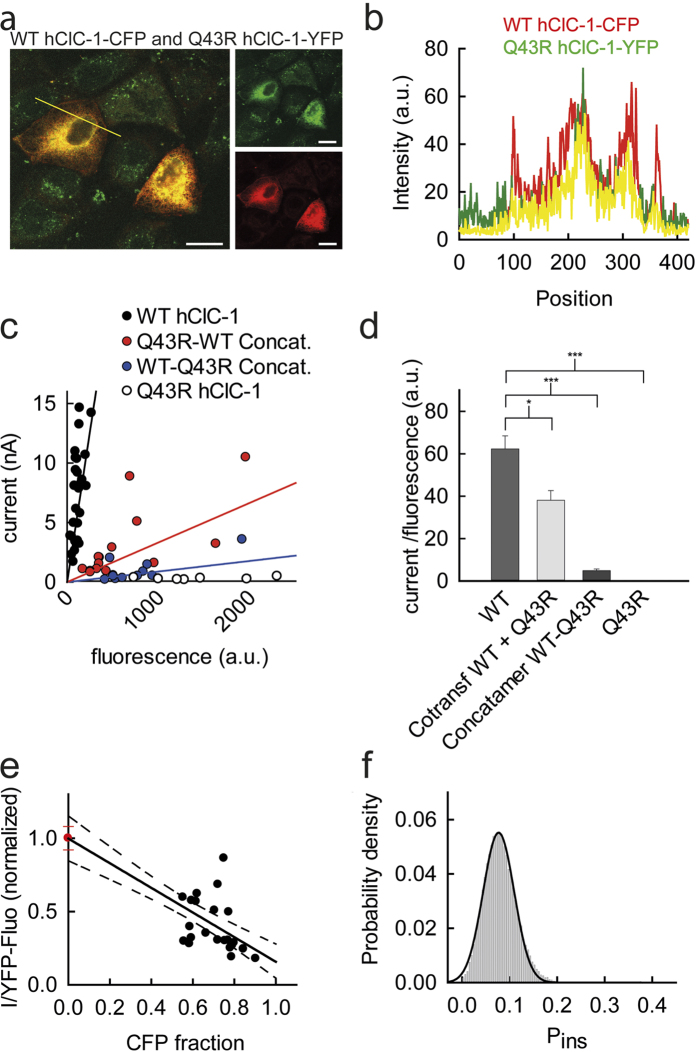
Heterodimeric channels assembled from WT and Q43R hClC-1 exhibit a reduced surface membrane insertion probability.(a,b) Confocal image (a) and corresponding profile intensities (b) for MDCK II cells co-expressing mYFP tagged WT and CFP-tagged Q43R hClC-1. Cells were co-transfected with 0.2 μg pSVL-mYFP-WT hClC-1 and 0.5 μg pSVL-mCFP-Q43R hClC-1. (c) Correlation between instantaneous current amplitude at −135 mV and whole-cell fluorescence for cells expressing WT or Q43R homodimers, or WT-Q43R or Q43R-WT heterodimeric concatamers. (d) Relative membrane insertion rates of homo- and heterodimers (means ± SEM from 11–23 experiments) (Student’s two-tailed t-test with *p < 0.05 and ***p < 0.001). (e) Plot of the current by YFP fluorescence ratio versus the CFP fluorescence from 21 cells co-expressing WT hClC-1-mYFP and Q43R hClC-1-CFP. I/FYFP was normalized to values obtained for WT hClC-1-YFP in absence of Q43R hClC-1-CFP (fraction of CFP = 0). The y-axis intercept is determined by the mean current by fluorescence ratio from 29 cells that exclusively express WT hClC-1-YFP (shown as mean ± SEM in red). (f) Distribution of estimated surface membrane insertion probabilities from 50,000 bootstrap samples of the original data. Histograms have been normalized such that the integral over the range is 1 and fitted with a Gaussian function (μ=0.081, σ = 0.034).